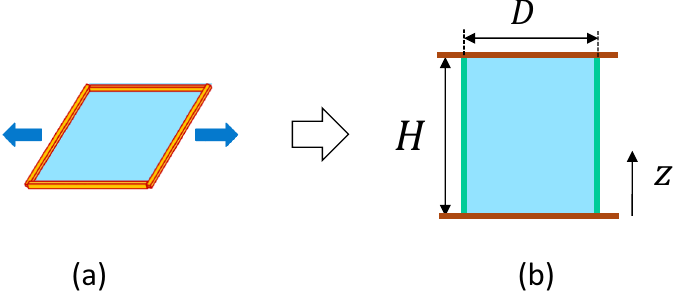
Figure 7. ( a ) Frame or projected area to be fixed to measure the surface tension τ , which can be called frame tension, in the case of a square surface, and ( b ) projected area A = π DH is fixed to calculate τ in the case of a cylindrical